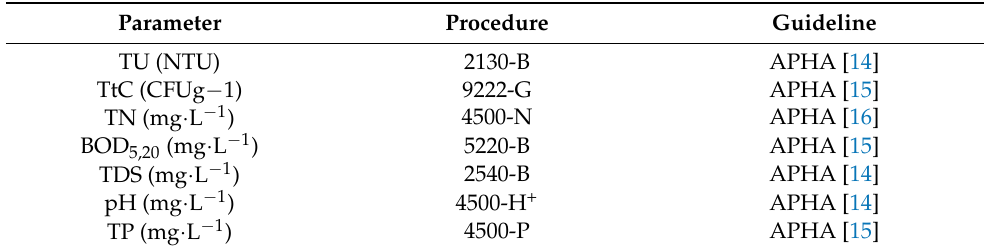
Table 1. Analysis procedures for the indicator